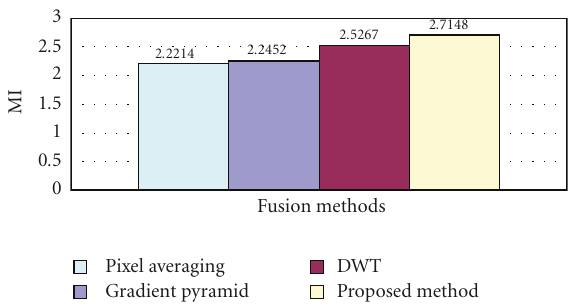
Figure 6: MI values of the four di ff erent